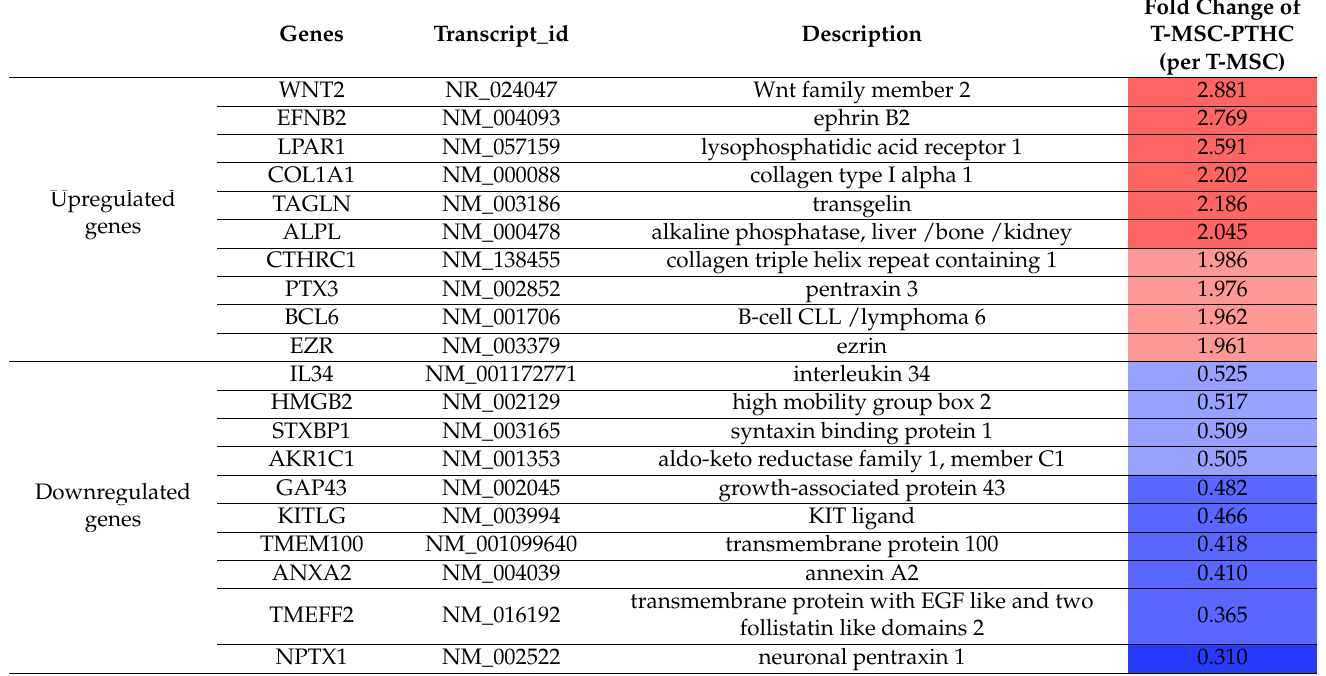
Table 2. List of upregulated and downregulated differentiation-related genes in T-MSC-PTHCs. Genes Transcript_id Description